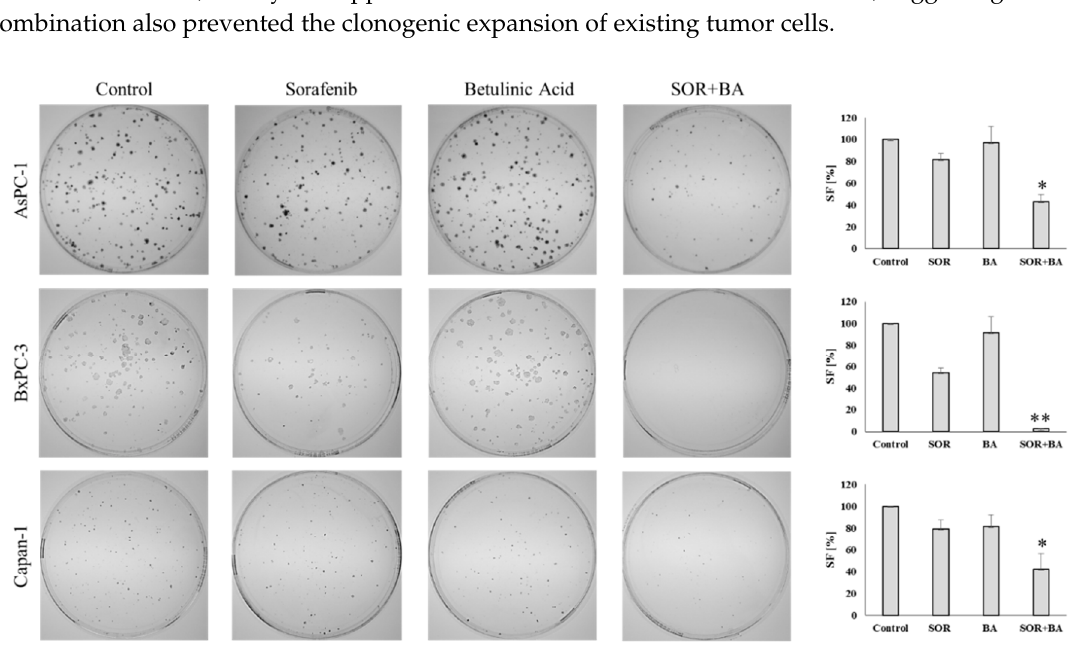
Figure 5. Effect of combination treatment with SOR and BA on the colony-forming ability of AsPC-1, BxPC-3, and Capan-1 cell lines. On the left: representative images of colonies formed by AsPC-1, BxPC-3, and Capan-1 cells after treatment with sorafenib (AsPC-1 and Capan-1: 5 µM, BxPC-3: 3 µM) and betulinic acid (6 µM) alone and in combination. On the right: the surviving fraction (SF) of AsPC-1, BxPC-3, and Capan-1 cells after treatment with sorafenib (AsPC-1 and Capan-1: 5 µM, BxPC-3: 3 µM) and betulinic acid (6 µM) alone and in combination ( n = 3). * p < 0.05 ** p < 0.01 compared with